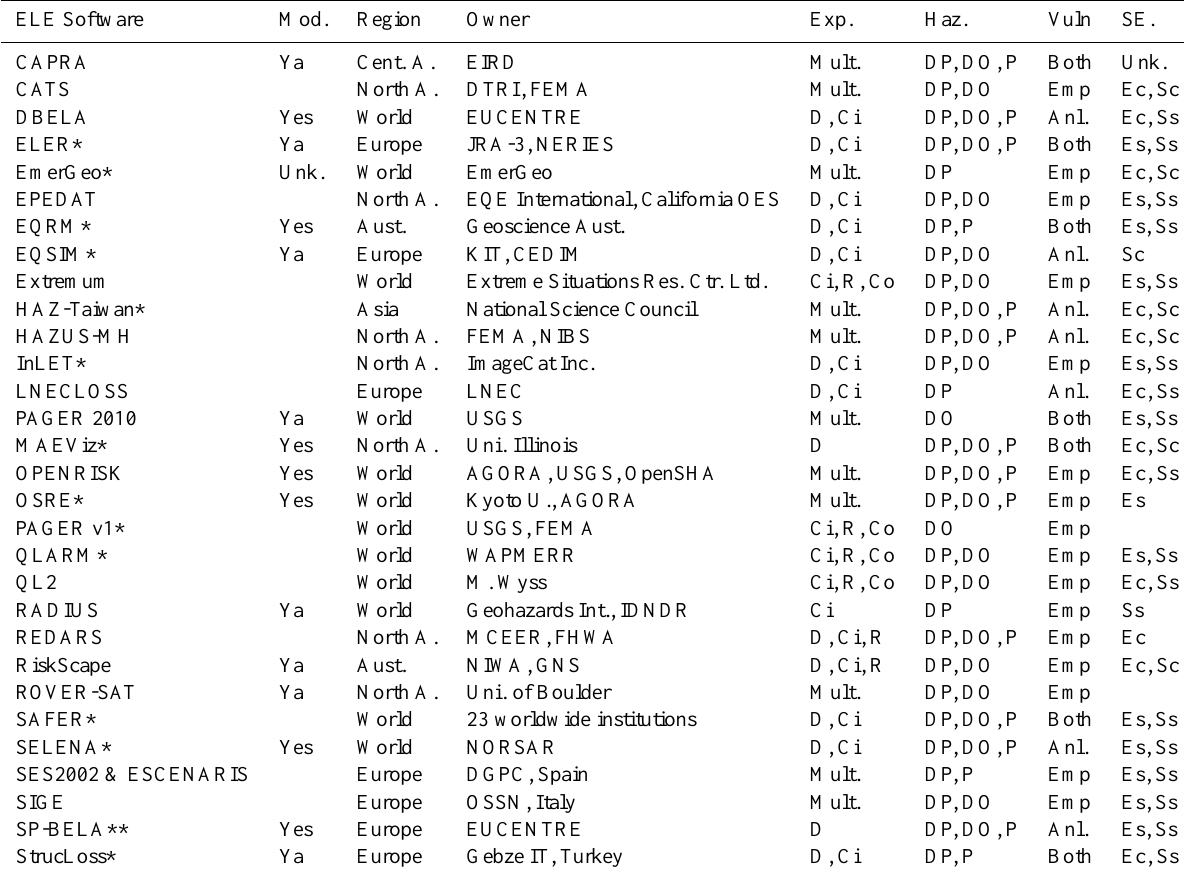
Table 1. A synopsis of the components of 30 mostly open source worldwide ELE software packages. ELE Software Mod. Region Owner Exp. Haz. Vuln SE. CAPRA Ya Cent. A. EIRD Mult. DP, DO, P Both Unk. CATS North A. DTRI, FEMA Mult. DP, DO Emp Ec, Sc DBELA Yes World EUCENTRE D, Ci DP, DO, P Anl. Ec, Ss ELER* Ya Europe JRA-3, NERIES D, Ci DP, DO, P Both Es, Ss EmerGeo* Unk. World EmerGeo Mult. DP Emp Ec, Sc EPEDAT North A. EQE International, California OES D, Ci DP, DO Emp Es, Ss EQRM* Yes Aust. Geoscience Aust. DP, P Both Es, Ss Europe Anl. Sc Extremum World Extreme Situations Res. Ctr. Ltd. Emp Es, Ss HAZ-Taiwan* Asia National Science Council Mult. DP, DO, P Anl. Ec, Sc HAZUS-MH North A. FEMA, NIBS Mult. DP, DO, P Anl. Ec, Sc InLET* North A. ImageCat Inc. Es, Ss LNECLOSS Europe LNEC Anl. Ec, Ss PAGER 2010 Ya World USGS Mult. DO Both Es, Ss MAEViz* Yes North A. Uni. Illinois DP, DO, P Both Ec, Sc OPENRISK Yes World AGORA, USGS, OpenSHA Mult. DP, DO, P Emp Ec, Ss OSRE* Yes World Kyoto U., AGORA Mult. DP, DO, P Emp Es PAGER v1* World USGS, FEMA Ci, R, Co DO Emp QLARM* World WAPMERR Ci, R, Co DP, DO Emp Es, Ss QL2 World M. Wyss Ci, R, Co DP, DO Emp Ec, Ss RADIUS Ya World Geohazards Int., IDNDR Ci DP Emp Ss REDARS North A. MCEER, FHWA D, Ci, R DP, DO, P Emp Ec RiskScape Ya Aust. NIWA, GNS D, Ci, R DP, DO Emp Ec, Sc ROVER-SAT Ya North A. Uni. of Boulder Mult. Emp SAFER* World 23 worldwide institutions Both Es, Ss SELENA* Yes